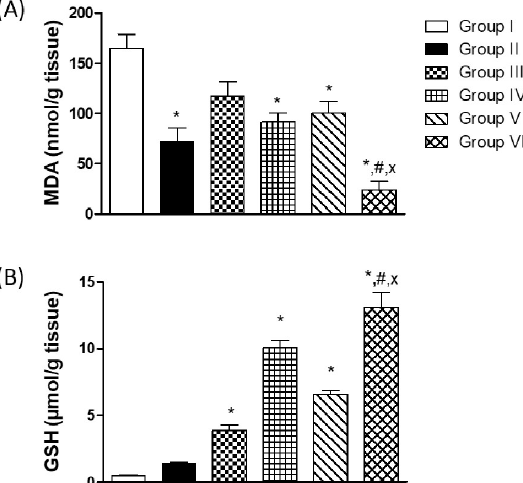
Fig 6. Thiobarbituric acid reactive substances (TBARS) level expressed as malondialdehyde (MDA) (A) and reduced glutathione in the wound tissues (B). Values are given as mean ± SEM (n = 6). � ,#,x indicates p < 0.05, compared to Group I, IV and V, respectively. Results were analyzed using one-way ANOVA followed by Tukey’s test.